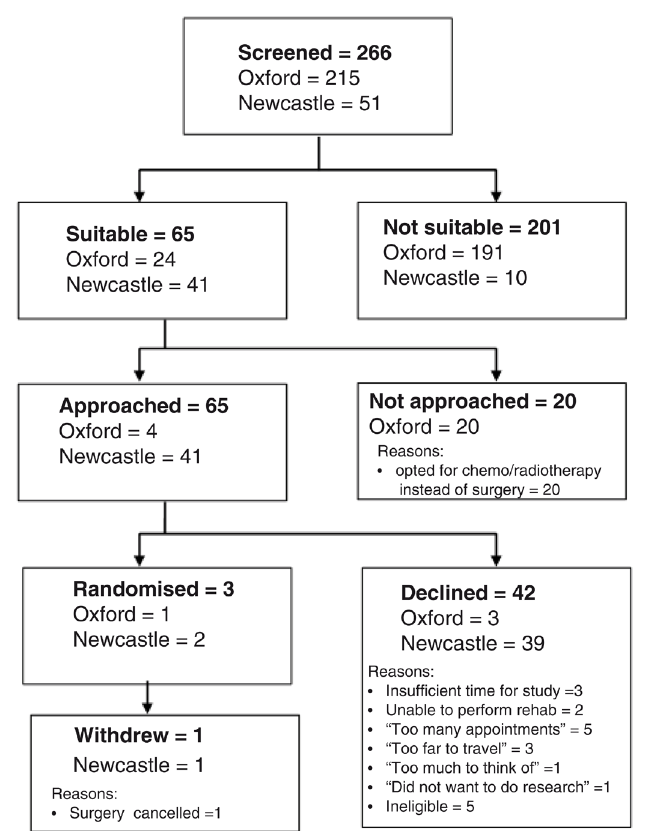
Figure 2. Flow diagram of participant identification and